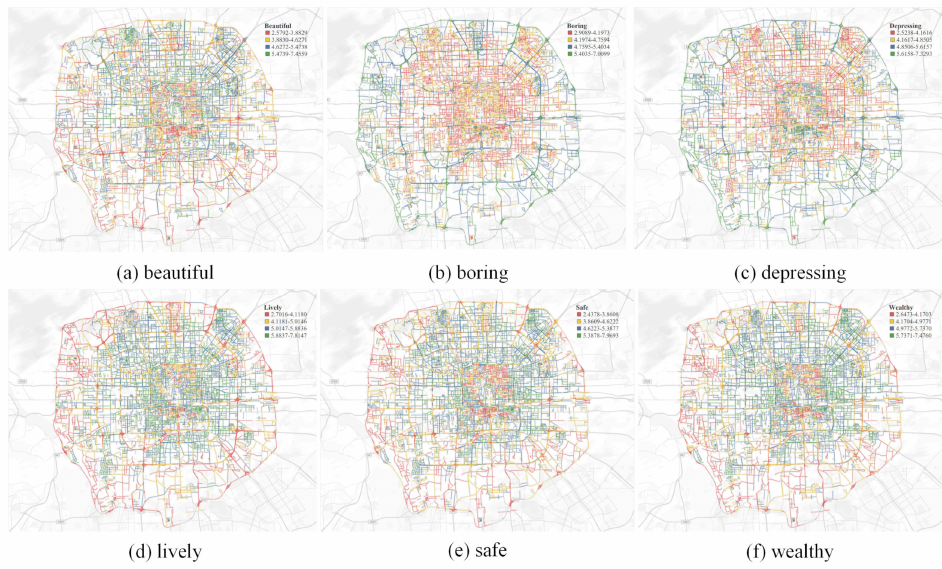
Figure 6. Spatial distribution of the human perceptions with six perceptual attributes in